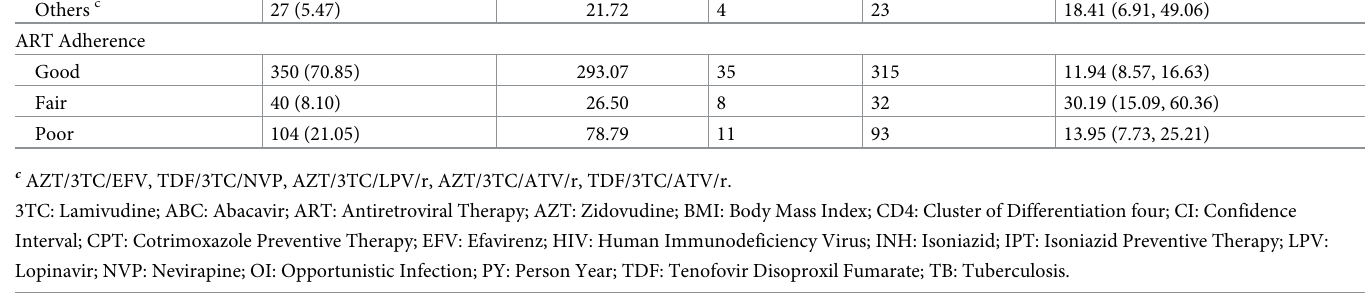
PLOS ONE | https://doi.org/10.1371/journal.pone.0251648 May 14,